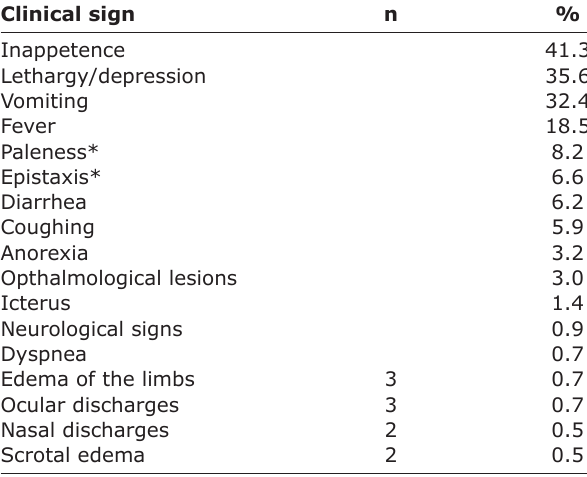
Table-3: Common clinical signs of E. canis sero- positive dogs in Metro Cebu, Philippines